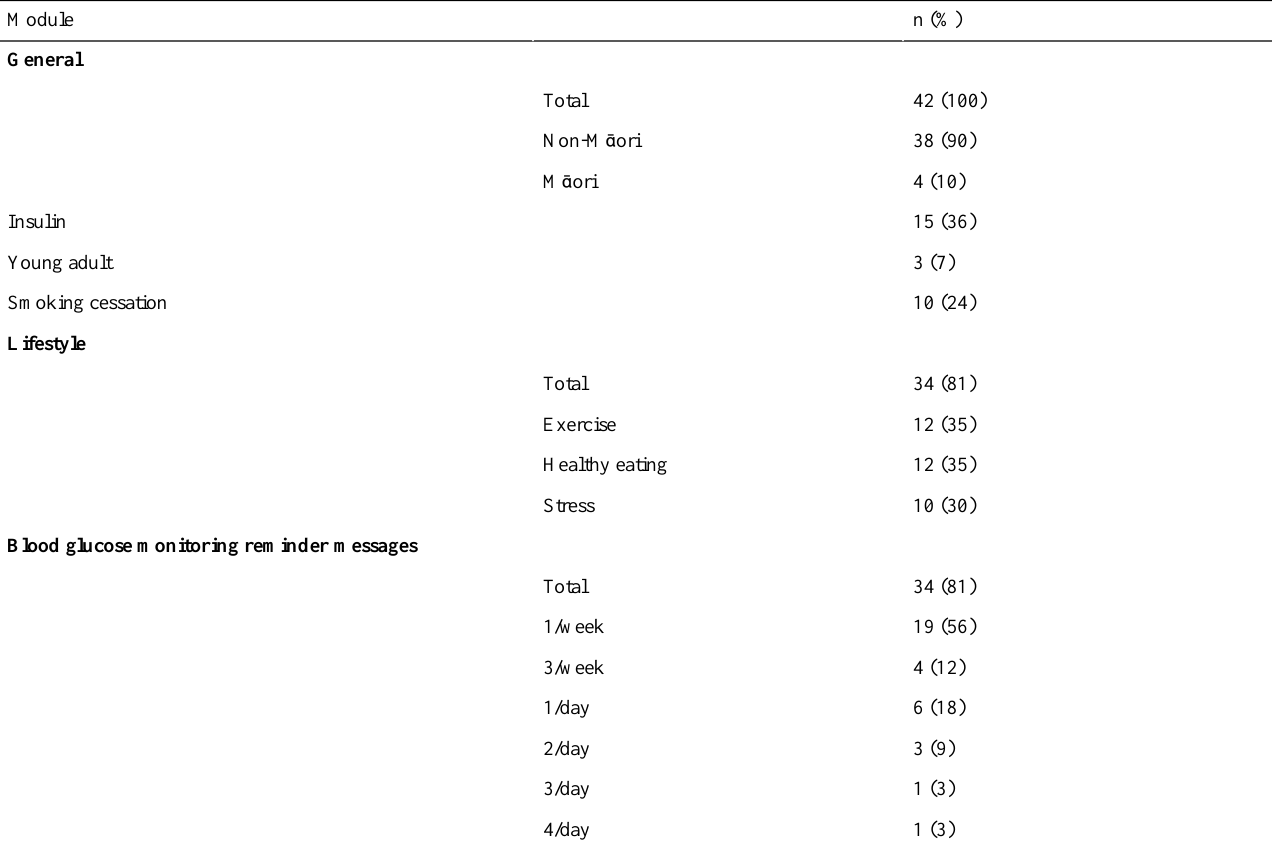
Table 3. Participants’choices of SMS4BG modules